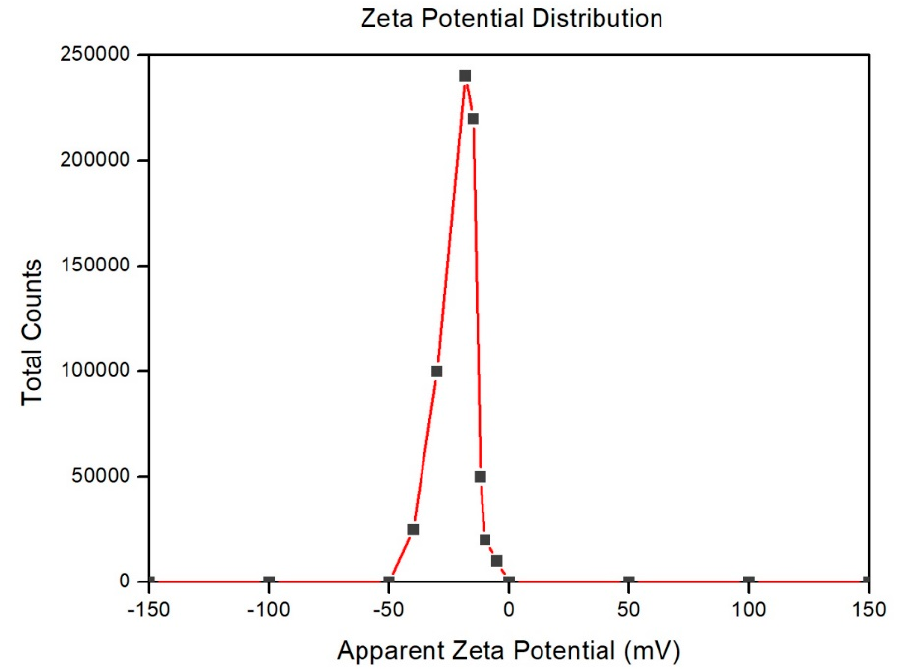
Figure 5. Zeta potential value of the SC-CO 2 extracted CNFs.